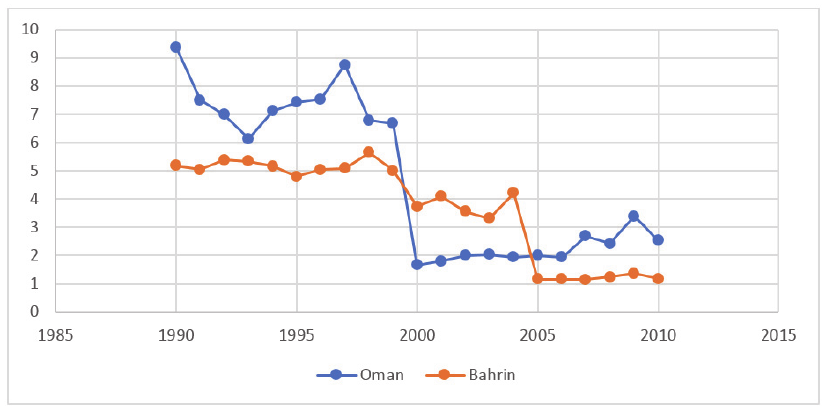
Fig. 1. Tax to GDP ratio of Bahrain and Oman from 1990 to